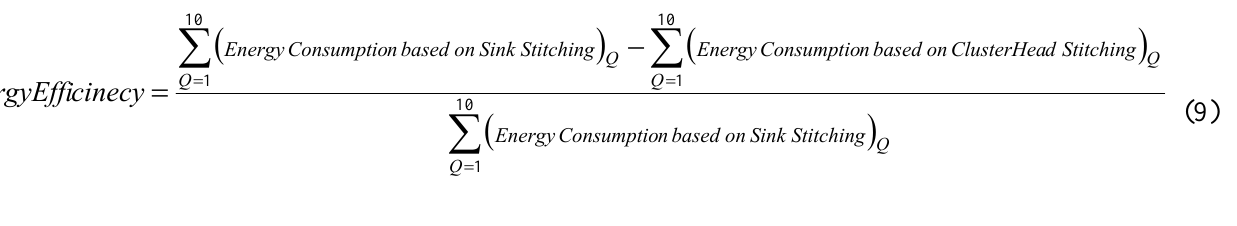
Figure 12. Network energy consumption for the queries 1 to